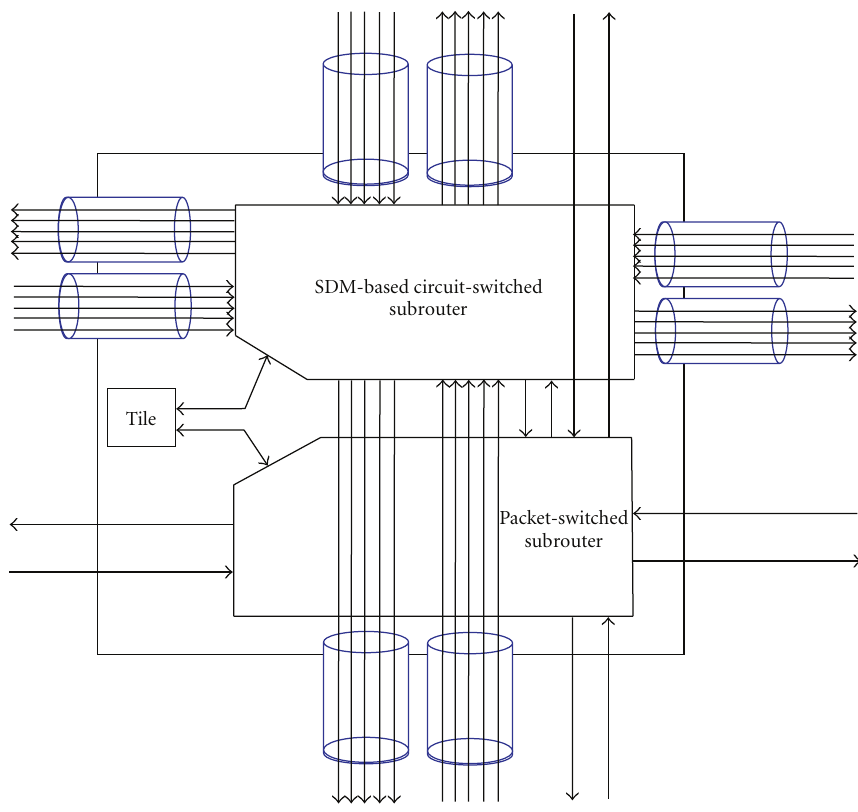
Figure 1: Hybrid SDM-based router